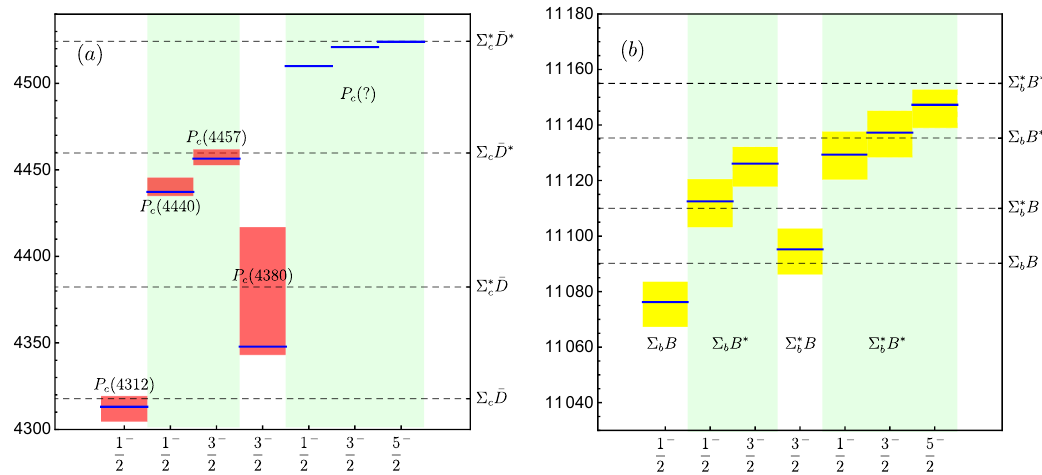
Figure 13 . The mass spectra of the hidden-charm ( a ) and hidden-bottom ( b ) molecular pen- taquarks. The red and yellow regions in (cid:12)gures ( a ) and ( b ) denote the mass ranges obtained from the experimental measurements and theoretical estimations, respectively. The blue solid lines repre- sent the central values in our calculations. The black dashed lines are the corresponding